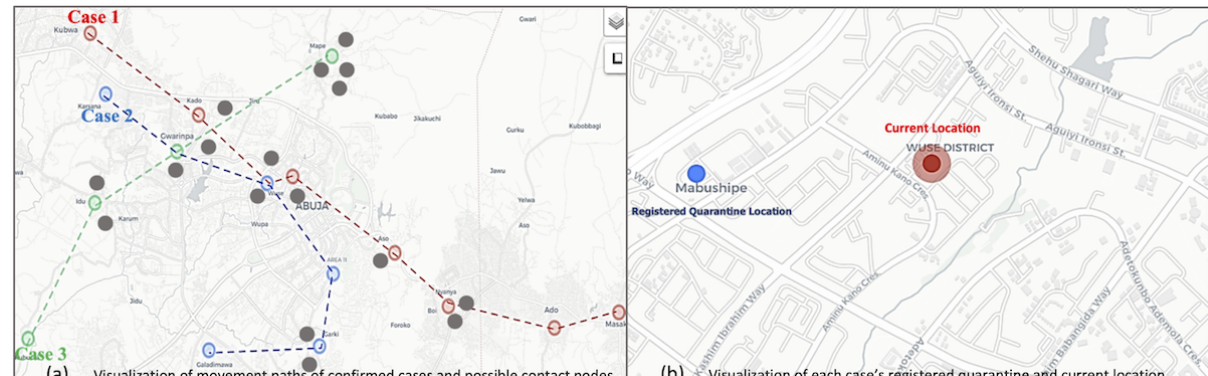
Figure 1. Visualization of Movement paths of cases and quarantine